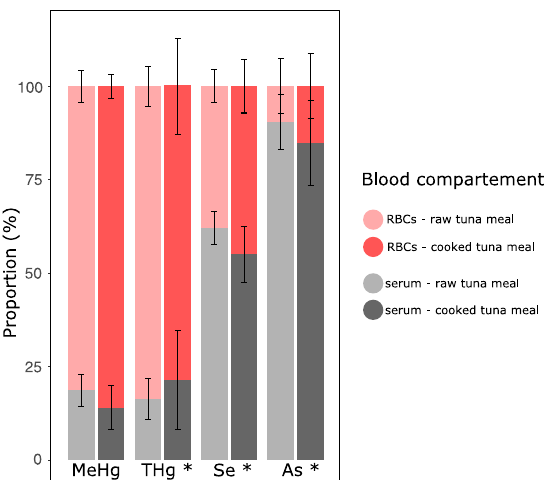
Figure 4. Mean ( ± SD) proportion (%) of the total quantity of different elements distributed between RBCs and the serum fraction over 540. min postprandial ( n = 34 and 35 for the raw tuna meal, adjusted to their respective volumes (RBC concentration was adjusted as a function of hematocrit (M RBC concentration × blood volume × hematocrit) and serum concentration as a function of serum volume (M serum concentration × blood volume × (1 − hematocrit)). * indicates that mean proportion varies as a function of time (time effect, p < 0.05). No difference was measured between the raw and cooked treatments (treatment effect, p >